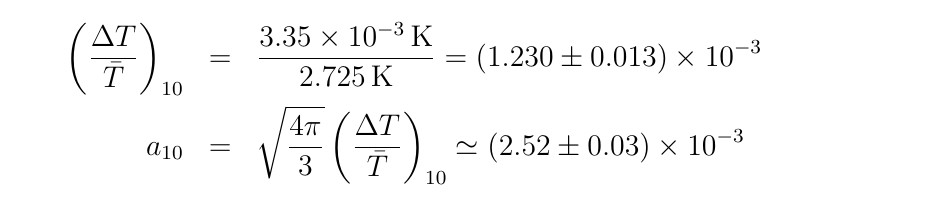
( r ) for Ω = 0 . 69 and various values 10 obs X, in . The dashed line corresponds to the observed value (whose 0